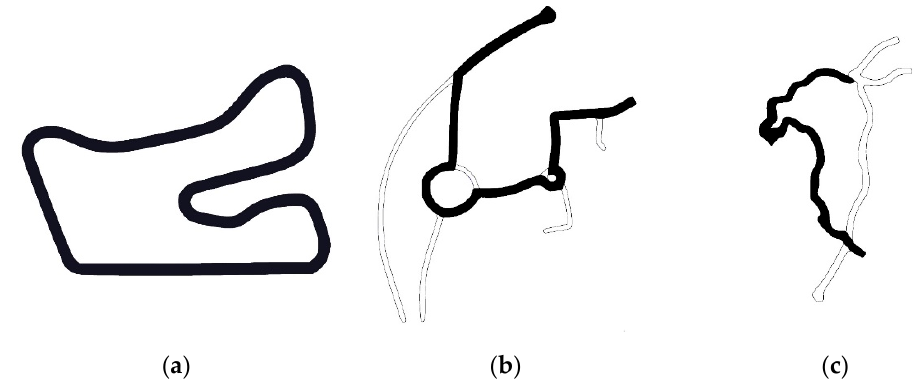
Figure 2. Selected tracks: ( a ) Hockenheimring; ( b ) Rural roundabouts road; ( c ) Heilbronn. for each direction. This curvy road contains inclinations and declinations. Additional user- defined stopping sections were used to induce acceleration and deceleration